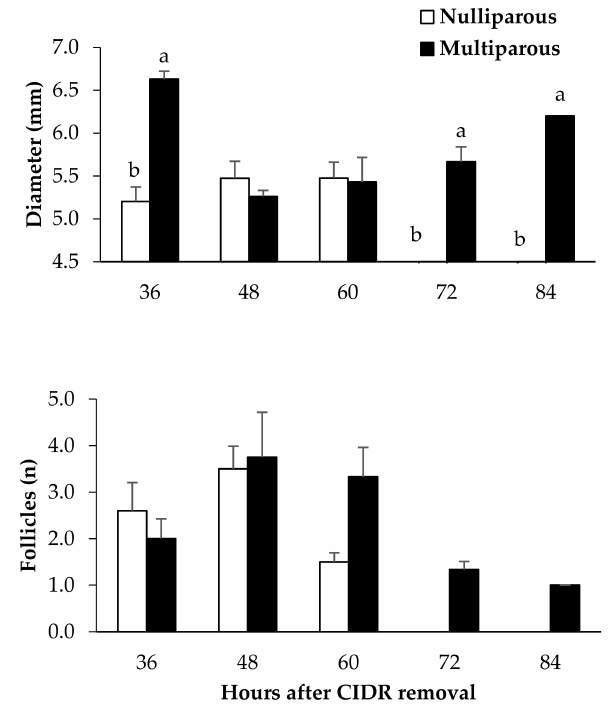
Figure 2. Mean ( ± ) follicle number and diameter in ewes that showed estrous activity after CIDR removal. Different letters indicate statistical differences between groups (a (cid:54) = b: p < 0.05). Our data show that 46.1 (5/13) of nulliparous ewes had a silent estrus, which was confirmed when assessing ovulation, because all the nulliparous ewes showed a corpus luteum (Table 2). Corpora luteum diameter was greater by 0.35 mm between multiparous vs. nulliparous ewes ( p < 0.05). Finally, the assessment of pregnancies evidenced a significant drop in the fertility and number of embryos in the nulliparous sheep. Table 2. Percentage and timing ( ± S.E.M.) of occurrence of ovulation, number of corpora lutea and fertility, and number of embryos in multiparous and nulliparous ewes after a short-term treatment with a controlled internal drug release (CIDR) and equine chorionic gonadotrophin (eCG) during seasonal anestrus.